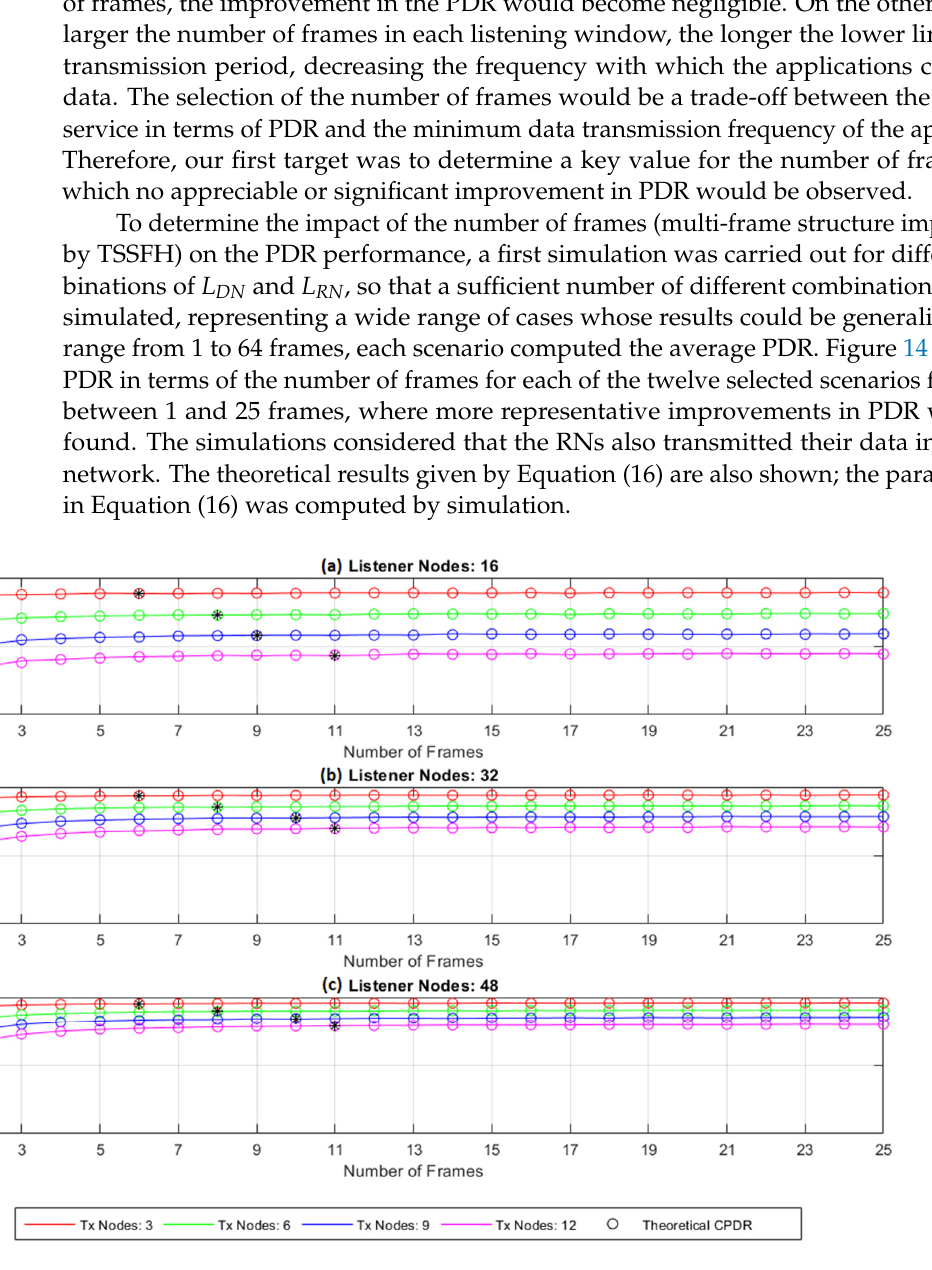
Figure 14. Collision-free packet delivery ratio (PDR) vs. number of frames. ( a ) 16 listener nodes; ( b ) 32 listener nodes; ( c ) 48 listener ( b ) 32 listener nodes; ( c ) 48 listener nodes.